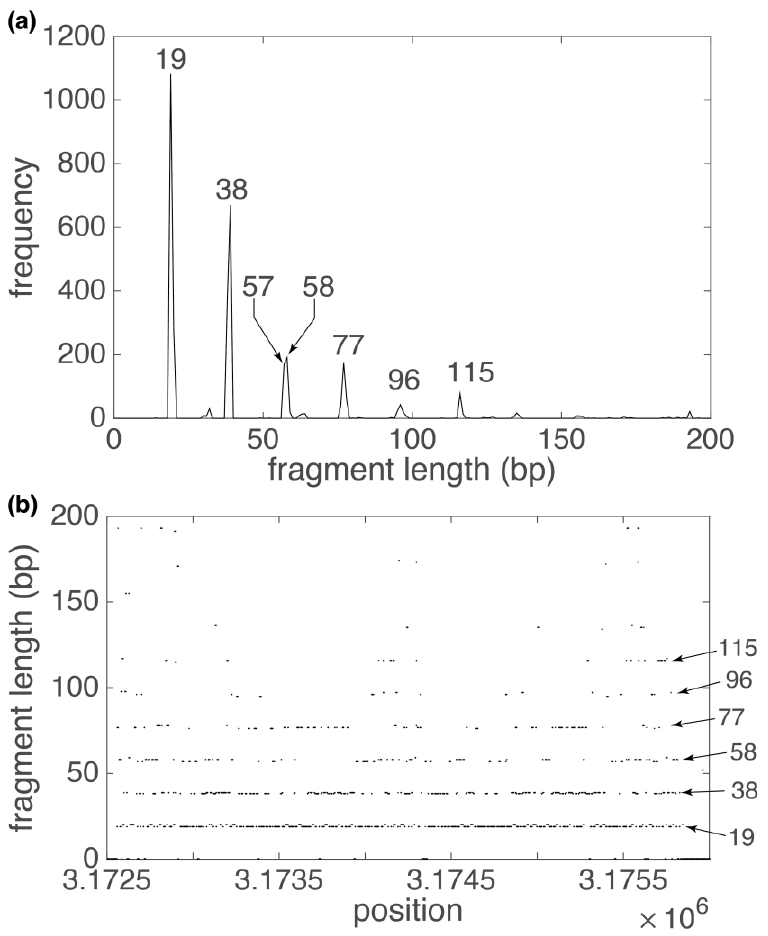
Figure 3. GRM diagram ( a ) and Fragment diagram ( b ) for 19 bp TR subarray in human chromosome 19 (Supplementary Table S1, repeat No. 254). ( a ) Pronounced GRM peaks at 𝑛 ∙ 19 bp correspond to basic repeat unit of 19 bp and its multiples. Deviations from perfect multiples of the basic unit occur due to insertions and deletions. ( b ) Each dot in the Fragment diagram corresponds to fragment length (component 𝑎 3𝑖 of vector 𝒂 𝑖 ) at that position (component 𝑎 1𝑖 of vector 𝒂 𝑖 ) . In the Fragment diagram, the density of the points decreases with increasing multiples of the basic repetitive unit, which corresponds to a decrease in the height of the peaks in corresponding GRM diagram.